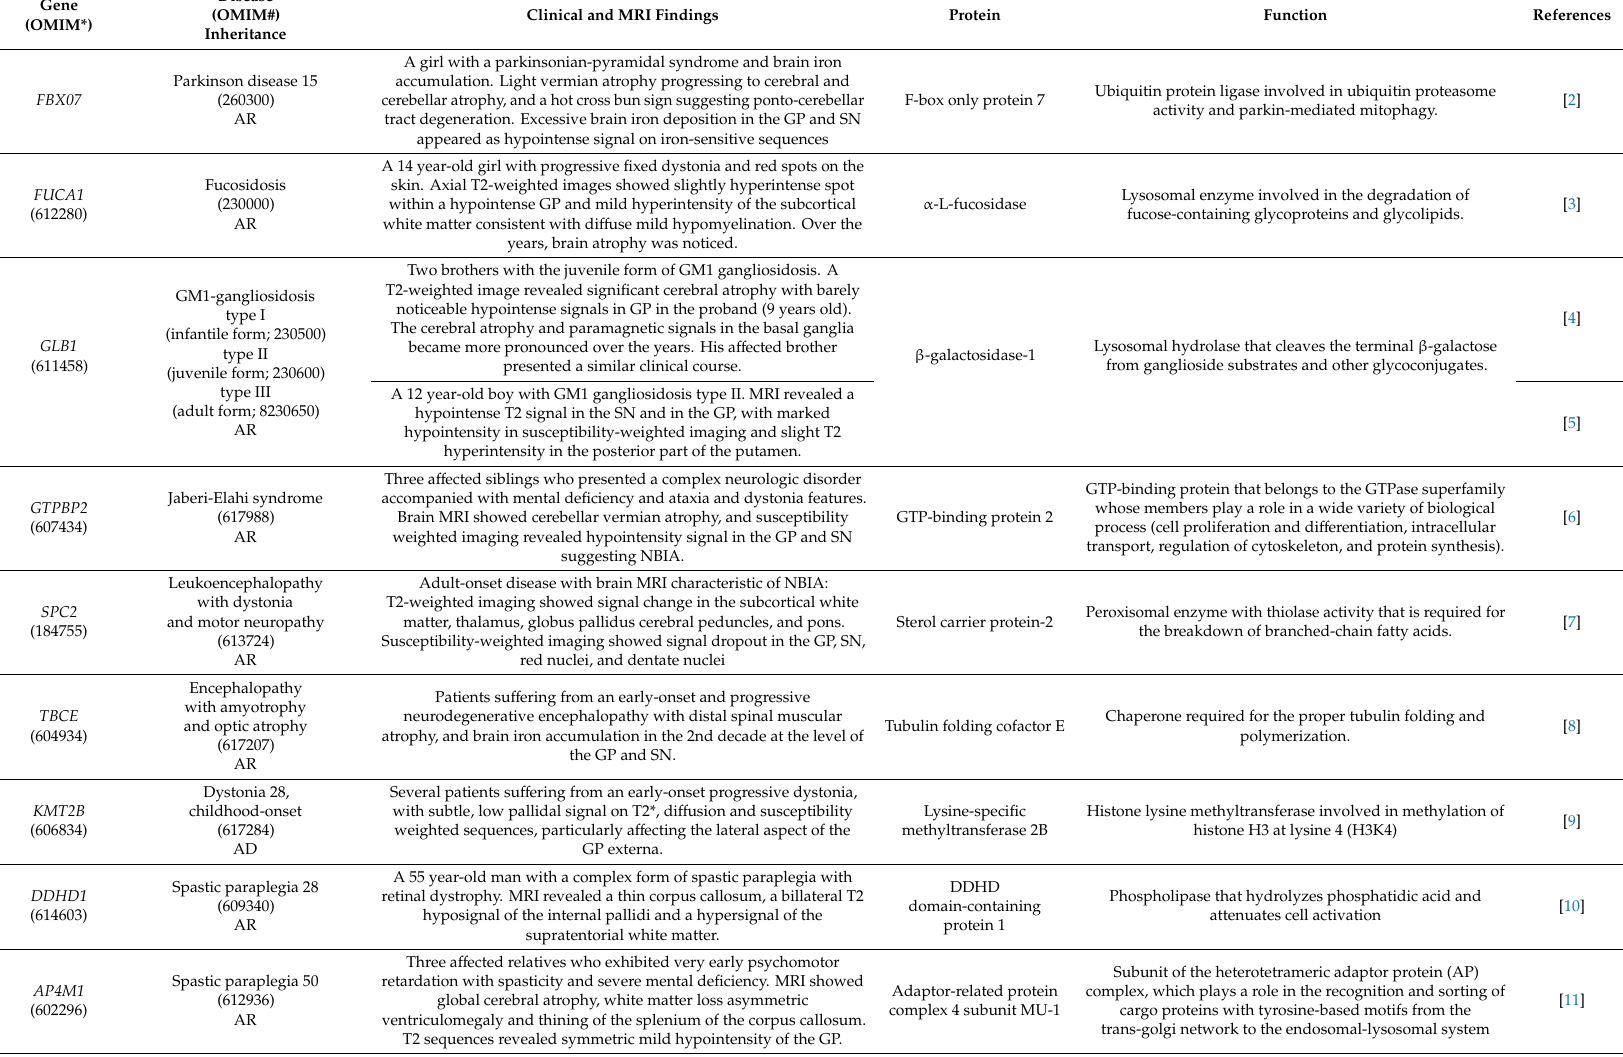
Table 2. NBIA-like